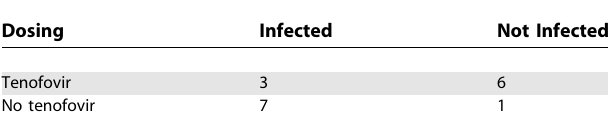
Table 2. Contingency Table for Dosing and Outcome of Virus Challenge: Analysis for ‘‘ Complete ’’ Protection (i.e., No Virus Detection) Associated with Tenofovir Gel Administered Intra- rectally Prior to Virus Challenge; p ¼ 0.05